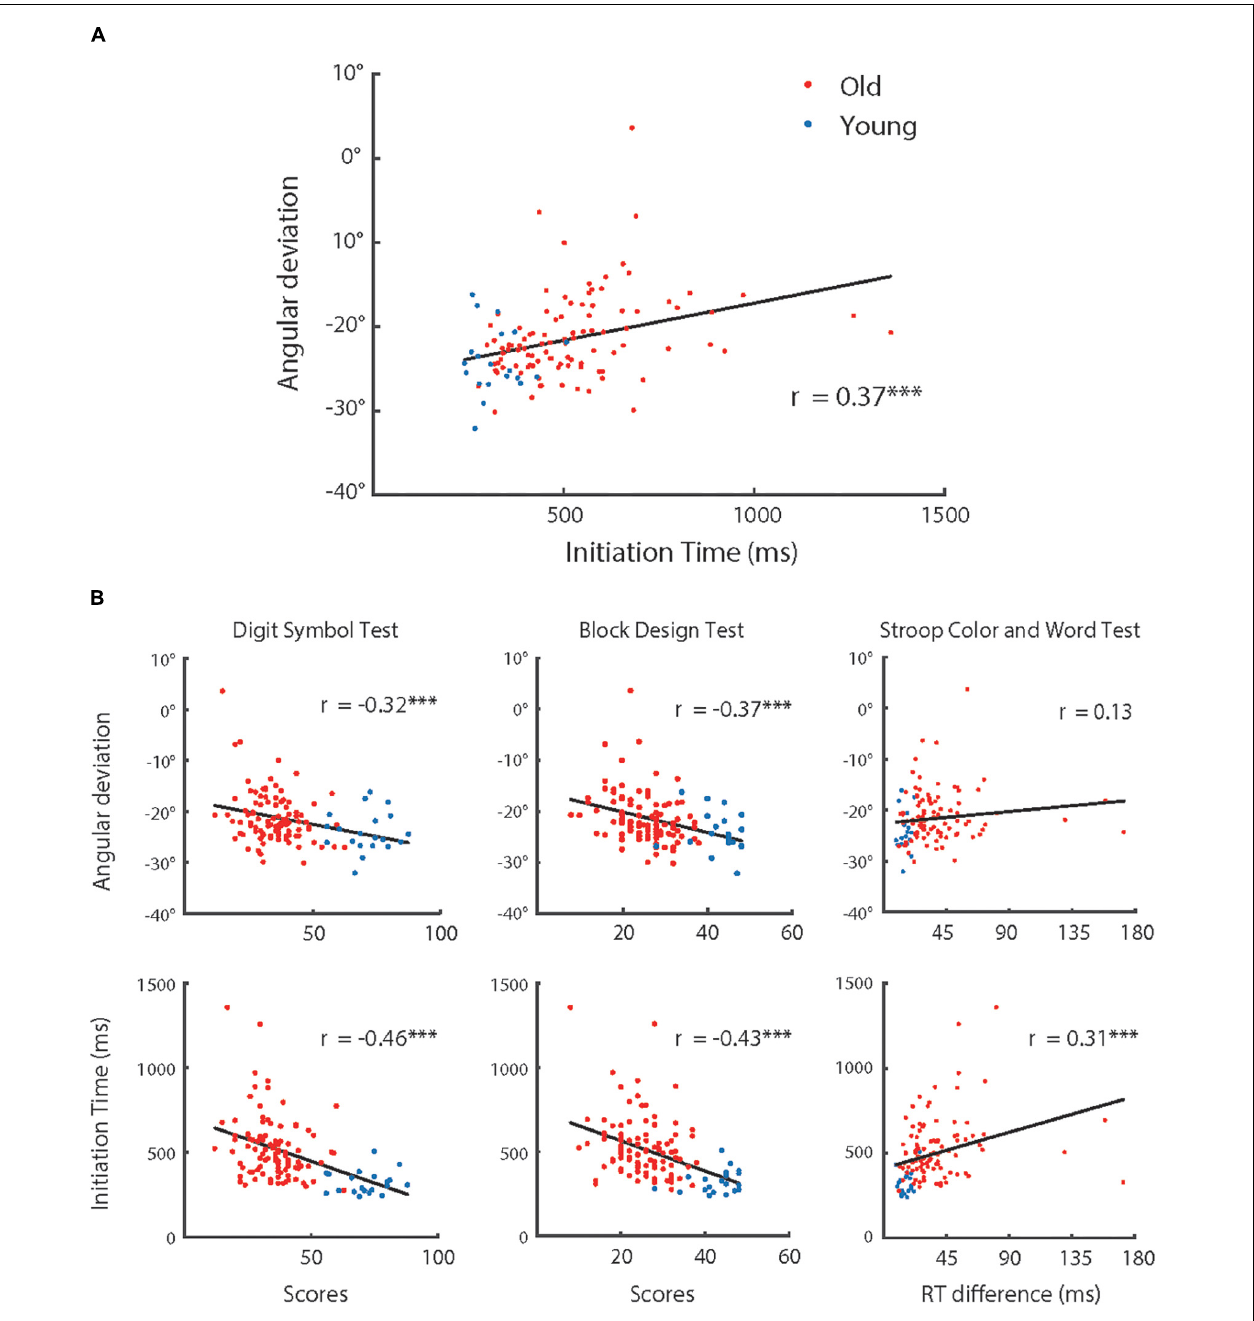
FIGURE 7 | (A) Adaptive angular deviation as a function of initiation time of hand movement, (B) adaptive angular deviation (upper row) and initiation time of hand movement (lower row) as functions of performance in cognitive tests (left: Digital Symbol Test; middle: Block Design Test; and right: Stroop Color and Word Test), respectively. The red dots represent the group of older participants ( n = 100) and the blue dots represent the group of younger participants ( n = 20). The solid lines indicate linear regression model fits and rs represent the Pearson correlations between variables. Note, ∗∗∗ p <